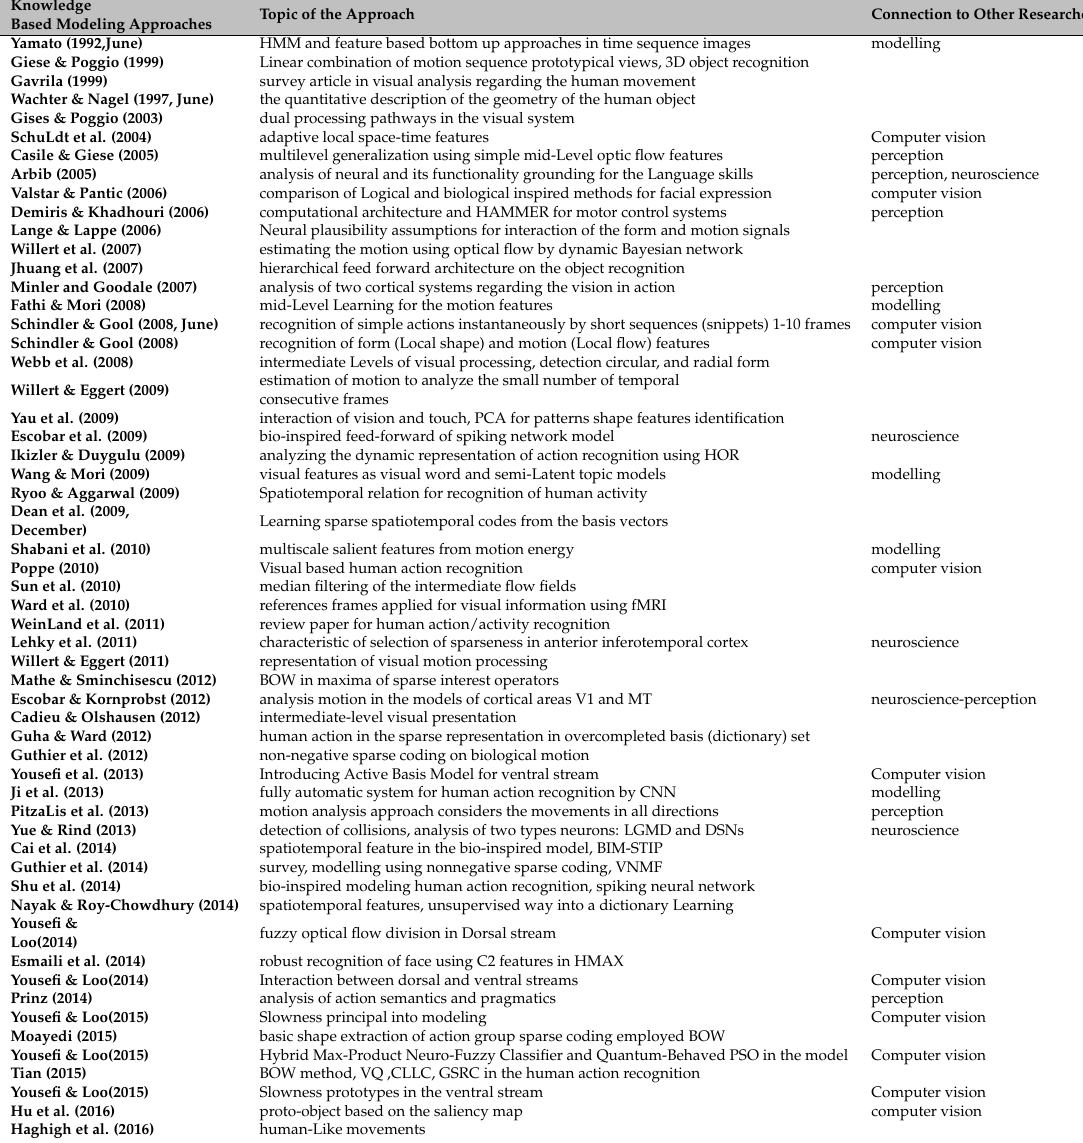
Table 3. The psychological and neuroscience approaches presented with their contribution in the